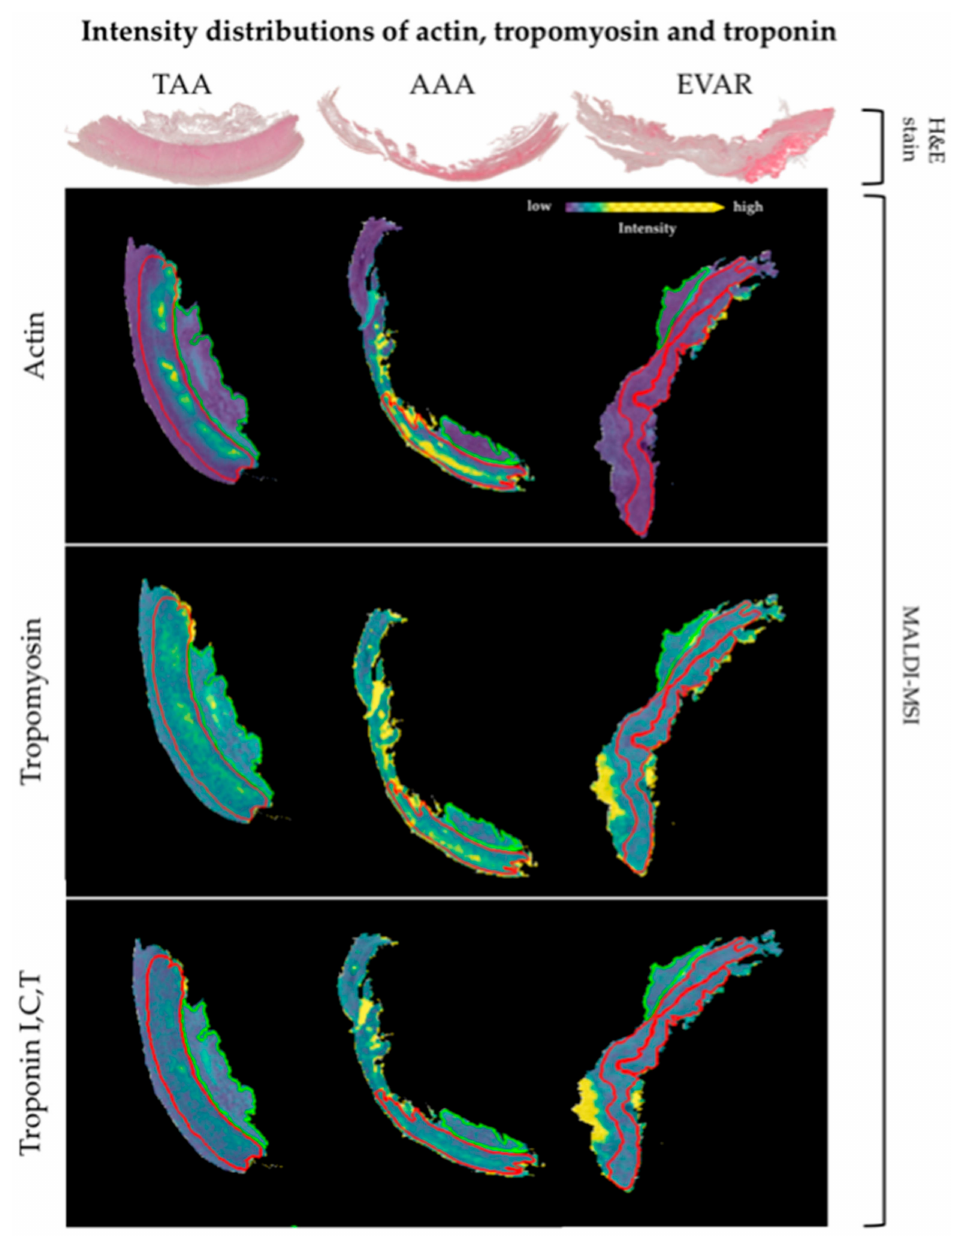
Figure 3. Differential intensity distributions of actin, tropomyosin, and troponin between TAA, AAA, and EVAR